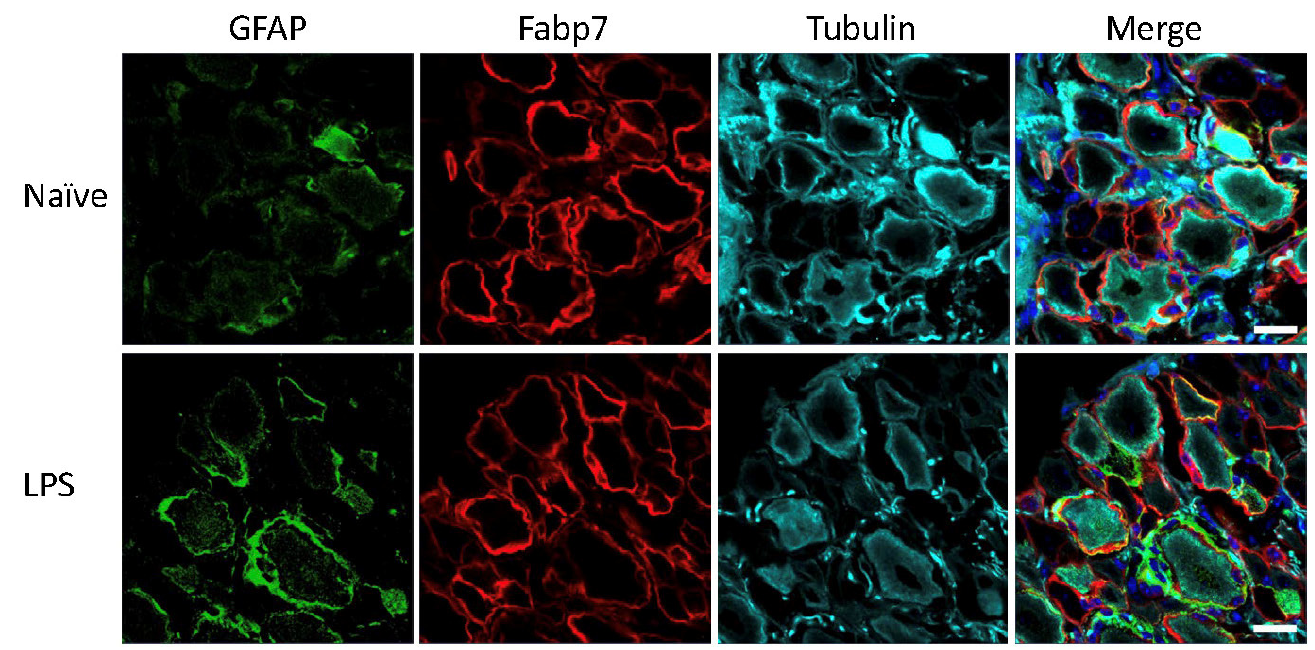
Figure 1. Rat lumbar DRG following LPS treatment. GFAP (green), SGC marker Fabp7 (red), neuronal b-tubulin (magenta), and Hoechst nuclear marker (dark blue, merge only). Scale bar = 20 µ m.